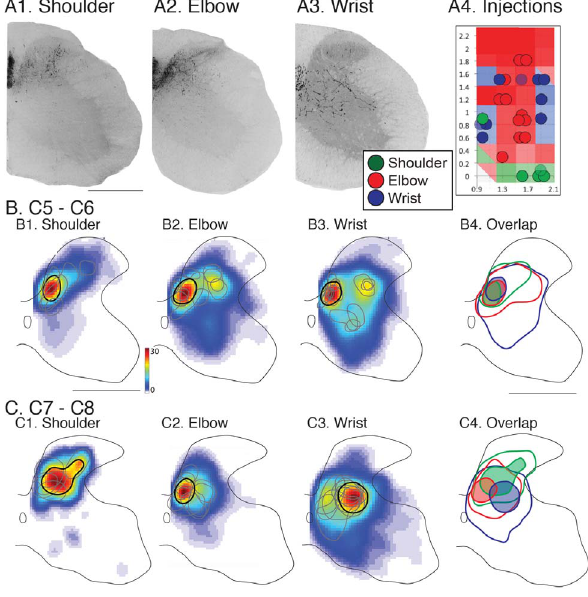
Figure 3. CST termination patterns from joint-specific motor cortex sites. Anterograde tracer injections were made into joint- specific sites in the motor cortex (A4; color code indicated in inset). Injection sites are shown overlaid on the joint probability map from Fig. 2G. Lightly shaded blue and green circles for wrist and shoulder respectively indicate injection sites where the dominant response and termination pattern were of the same group, yet was accompanied by a second smaller joint response at threshold. A1–3. Micrographs (inverted fluorescence images) of single sections showing CST labeling produced from injected (A1) shoulder, (A2) elbow, and (A3) wrist sites. B. Distribution of CST labeling at C5/C6. Average heatmaps for motor cortex shoulder elbow, and wrist sites (B1–B3). Black contours indicate the boundary of the high-density labeled region ( $ 60%) based on the averaged heatmap. Gray contours show high-density labeled region from each individual animal. B4 shows overlap of high-density (filled shapes) and low-density (10%; open shapes). Shading and line color according to the inset. C. Same as B, but for C7/C8. Color scale represents number of pixels per mm 2 . Scale bar=500 m